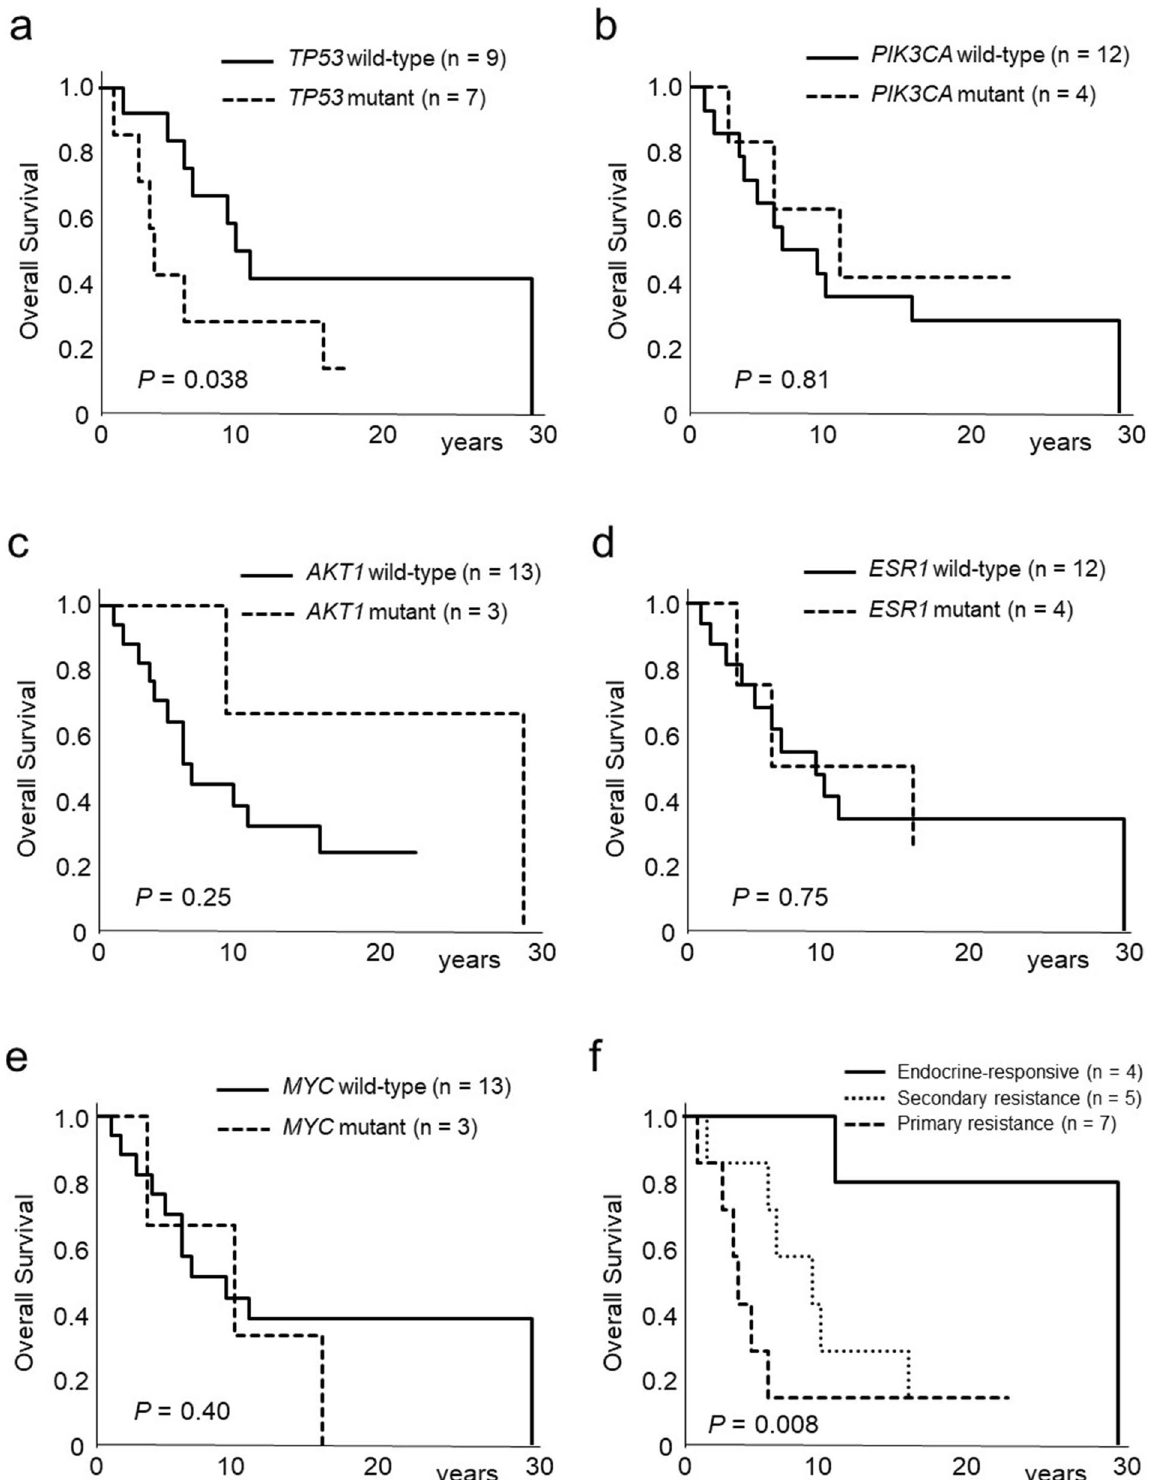
Figure 1. Kaplan–Meier curves of the effect of TP53 ( a ), PIK3CA ( b ), AKT1 ( c ), ESR1 ( d ), and MYC ( e ) gene alterations for overall survival in recurrent breast cancer patients. ( f ) Kaplan–Meier curves of the effect of endocrine responsiveness for overall survival in recurrent breast cancer